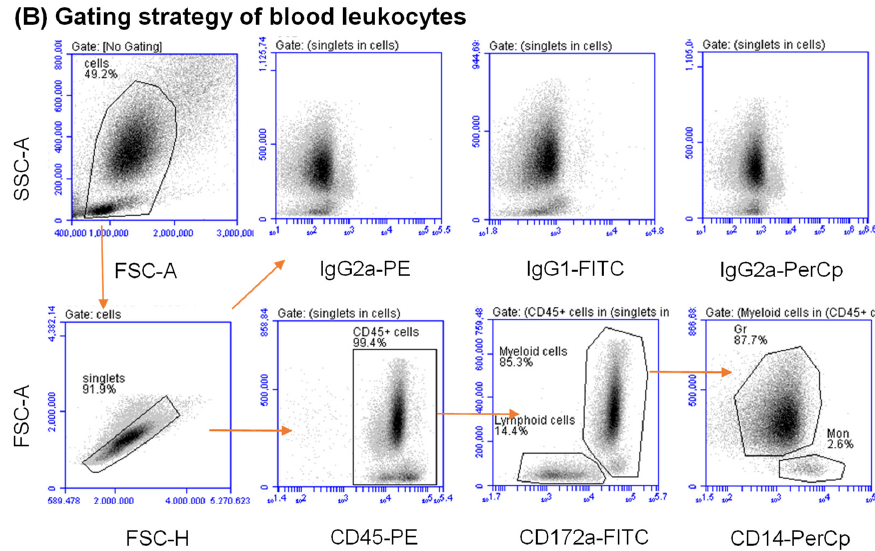
Figure 1. Flow cytometric analysis of leukocyte populations in the lung tissue and peripheral blood of dromedary camels. Lung cells ( A ) and blood leukocytes ( B ) were labeled with monoclonal antibodies to CD45, CD172a, and CD14 or with isotype control antibodies, and labeled cells were analyzed by flow cytometry. After the exclusion of cell debris in a SSC/FSC dot plot, a gate was set on single cells in a FSC-H against FSC-A dot plot. Total lung and total blood leukocytes were identified as CD45-positive cells. Lung and blood myeloid cells were differentiated from lymphoid cells based on their expression level of the myeloid marker CD172a. Lung macrophages and blood monocytes were identified based on their higher expression of the monocytic marker CD14 (CD172a high CD14 high ), while granulocytes were identified as CD172a high CD14 low cells. In comparison to their composition in peripheral blood, the leukocyte population in the lung tissue contained a lower percentage of myeloid cells (57.7 ± 3.1% versus 90.3 ± 1.9 of total CD45 + cells in the blood) and a higher percentage of lymphoid cells (42.2 ± 3.5%